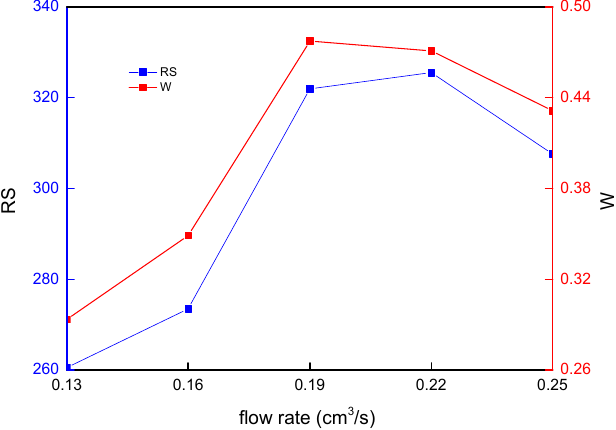
Figure 12. The effect of packing pressure on the residual stress and warpage.